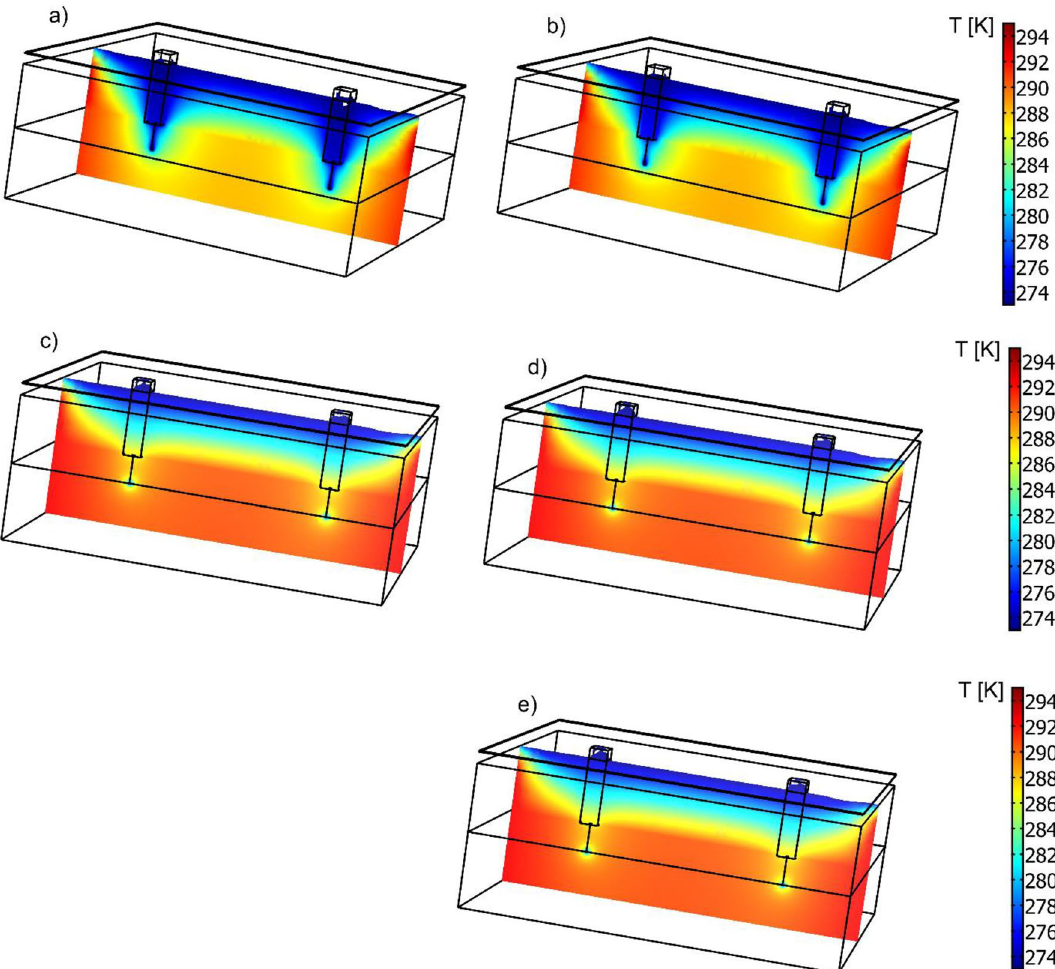
aluminum fastener, δ f = 2.75 mm, ( c ) stainless steel fastener δ f = 3 mm, ( d ) stainless steel fastener with holes, δ f = 3 mm, ( e ) stainless steel fastener δf = 2